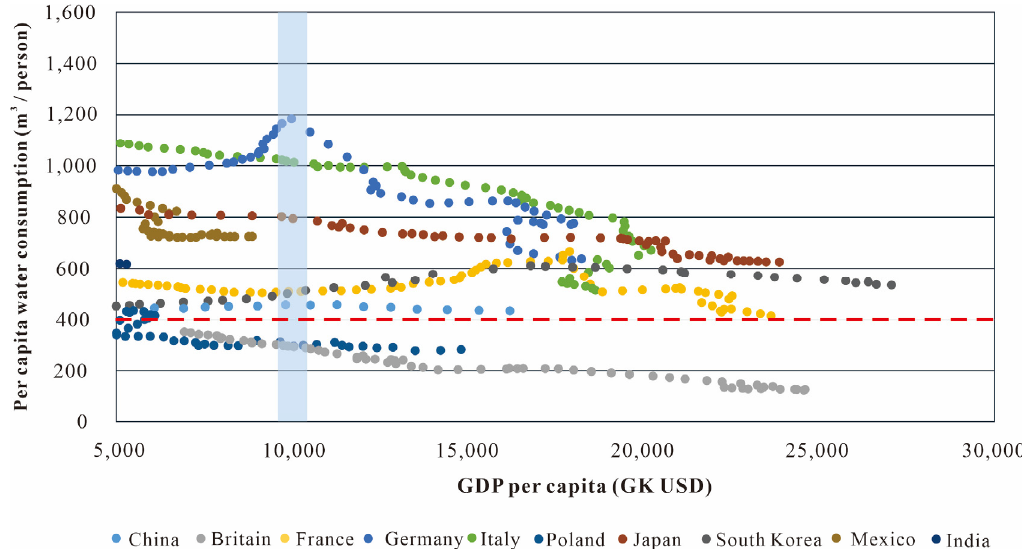
Figure 2. Relationship between per capita water consumption and per capita GDP.